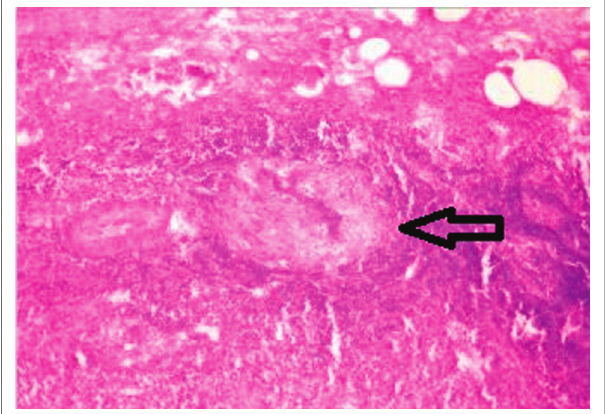
FIGURE 6: Histological specimen reveals a large granuloma of epithelioid cells (arrow) (haematoxylin-eosin, 600x).